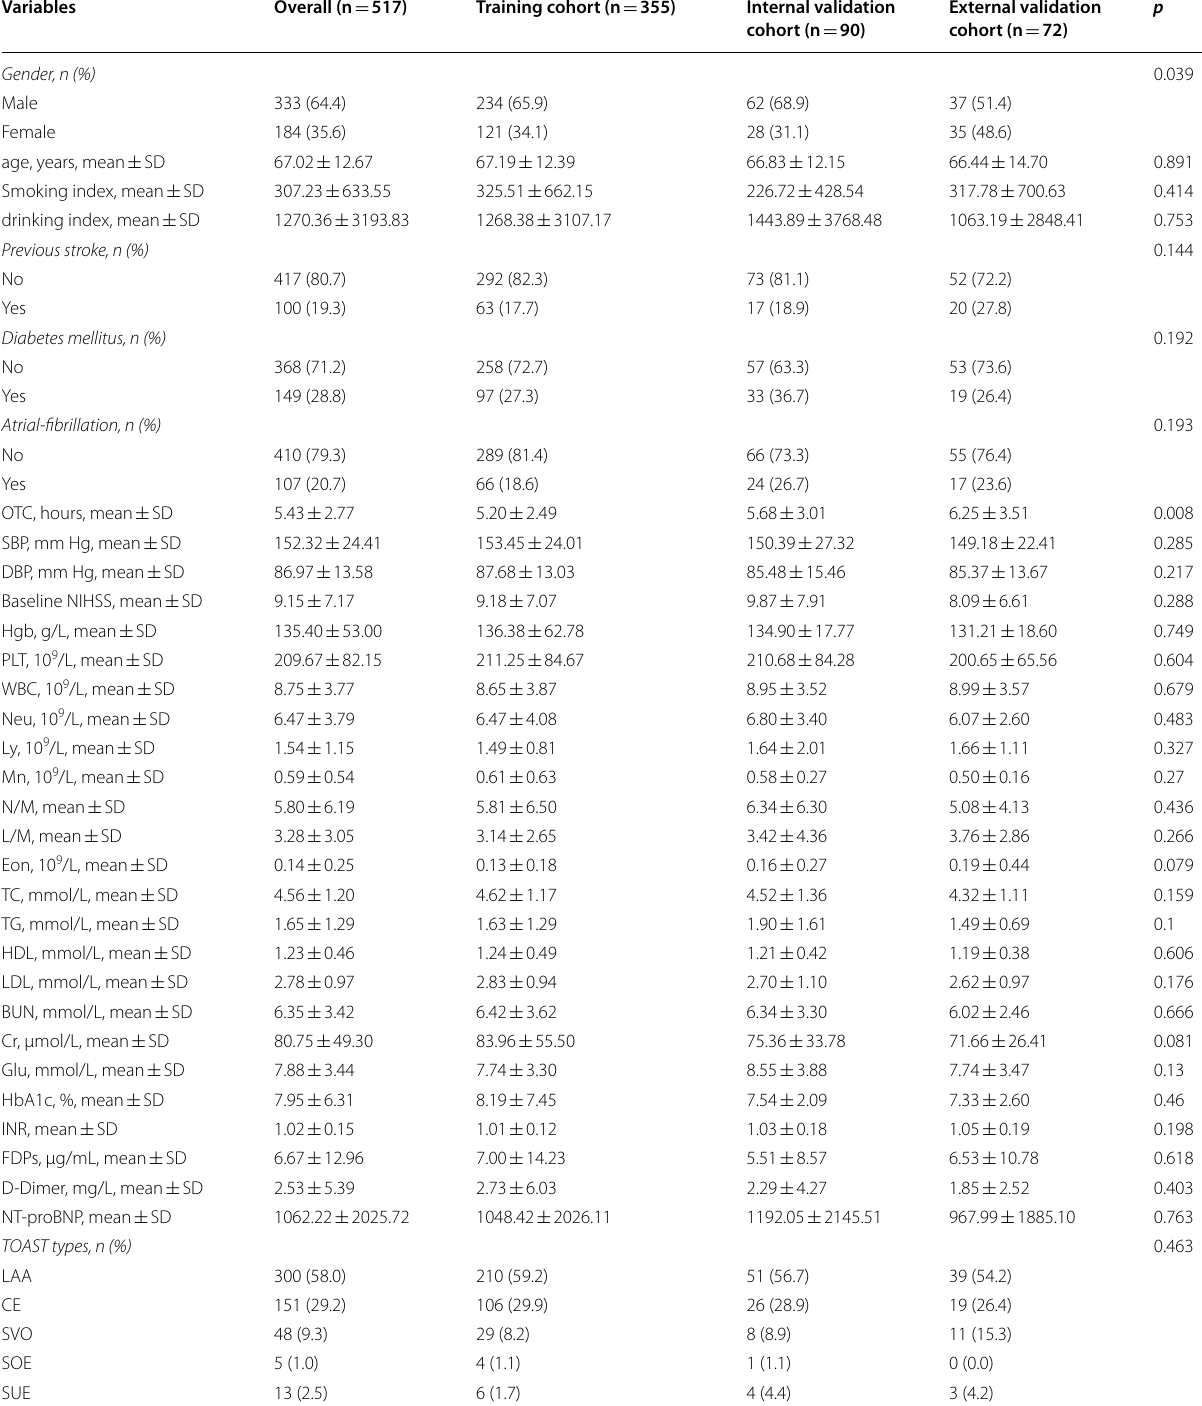
Table 1 Characteristics of all the